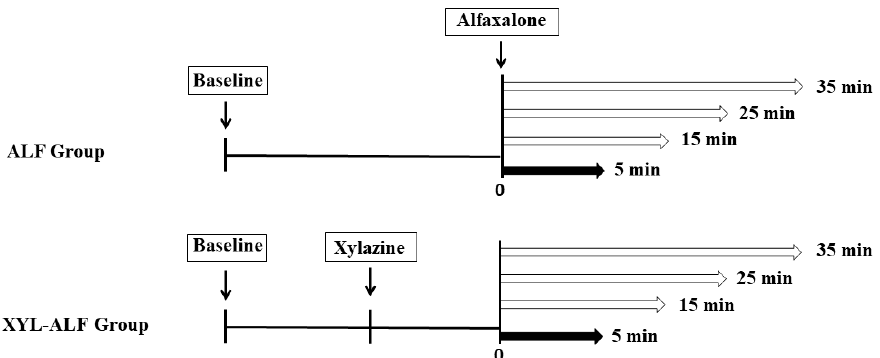
Figure 1. Study timeline illustrating the time of anesthetic induction with IV alfaxalone alone (ALF group) (n = 6) and with alfaxalone following IV xylazine administration (XYL-ALF) (n = 6). The data collection time points were at baseline and at 5, 15, 25 and 35 min after alfaxalone. The pedal withdrawal reflex and end tidal carbon dioxide (P E ’ CO 2 ) were recorded only at 5 min after alfaxalone administration (black